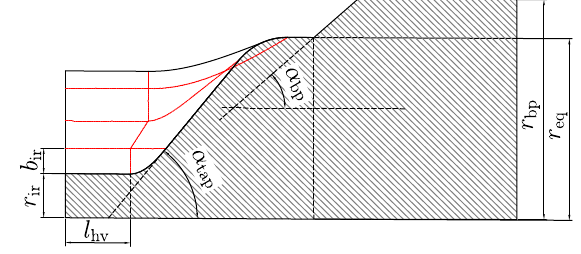
FIG. 15. Quarter of the longitudinal cross section of the four- vane cavity with beam pipe enhancement to allow the propaga- tion of the first dipole mode.